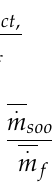
Table 1. Summary of soot and CO yields and effective heat of combustion for ABS and PVC combustibles. ABS PVC Effective Heat of Combustion, CO Yield, Soot Yield, ∆ H y CO y Soot e (MJ/kg) Average